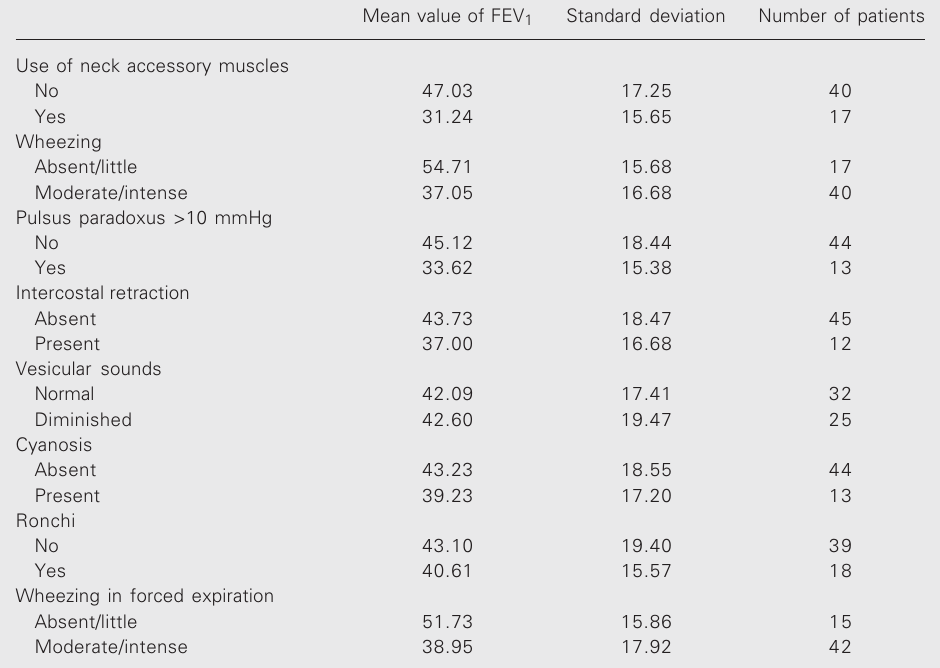
Table 5. Categorical variables observed in physical examination and forced expiratory volume at the first second (FEV 1 ; % predicted) measured in the emergency